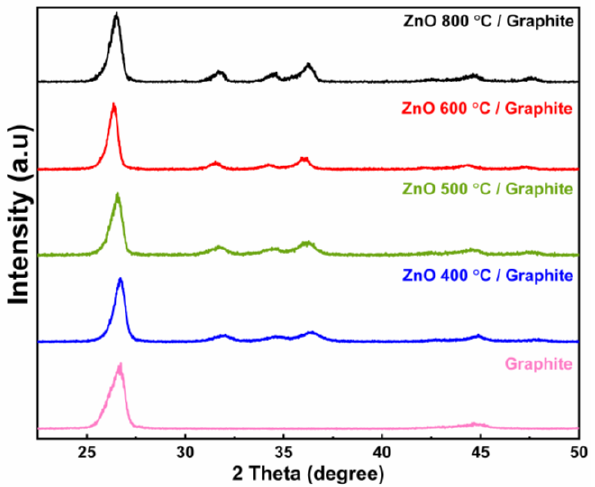
Figure 6. X-ray diffraction pattern of ZnO/graphite from various temperatures. Table 5. The crystallite size of ZnO graphite/powder samples. Samples